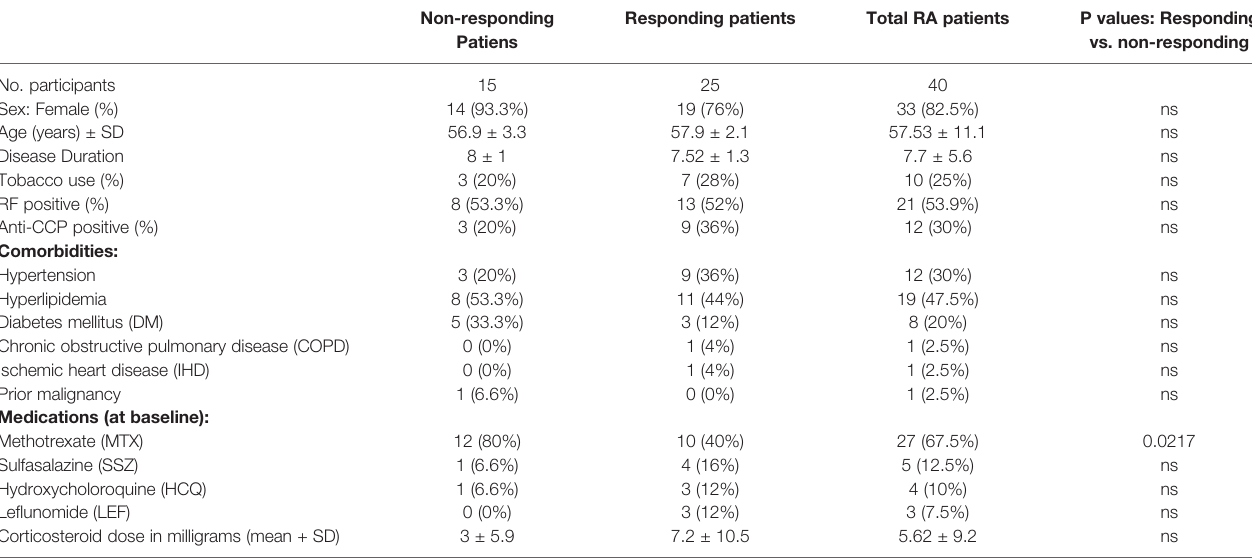
TABLE 1 | Demographic, clinical characteristics, underlying diseases, and treatment of the study groups. Non-responding